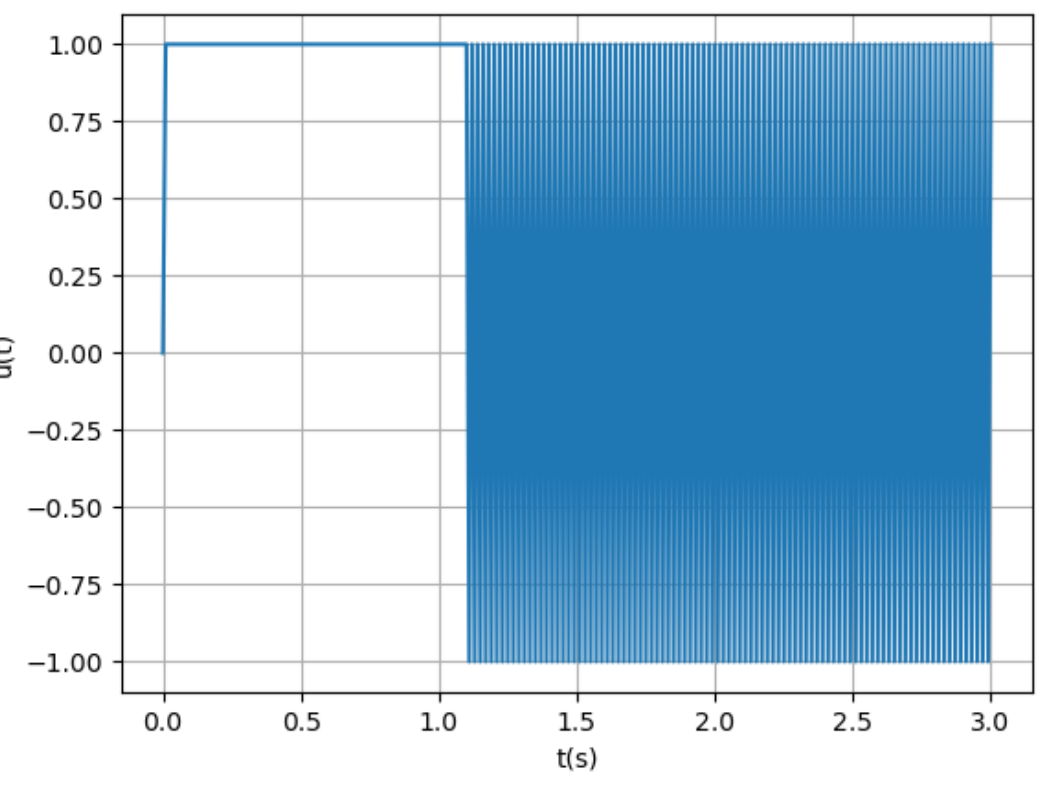
Figure 3. Resultant control